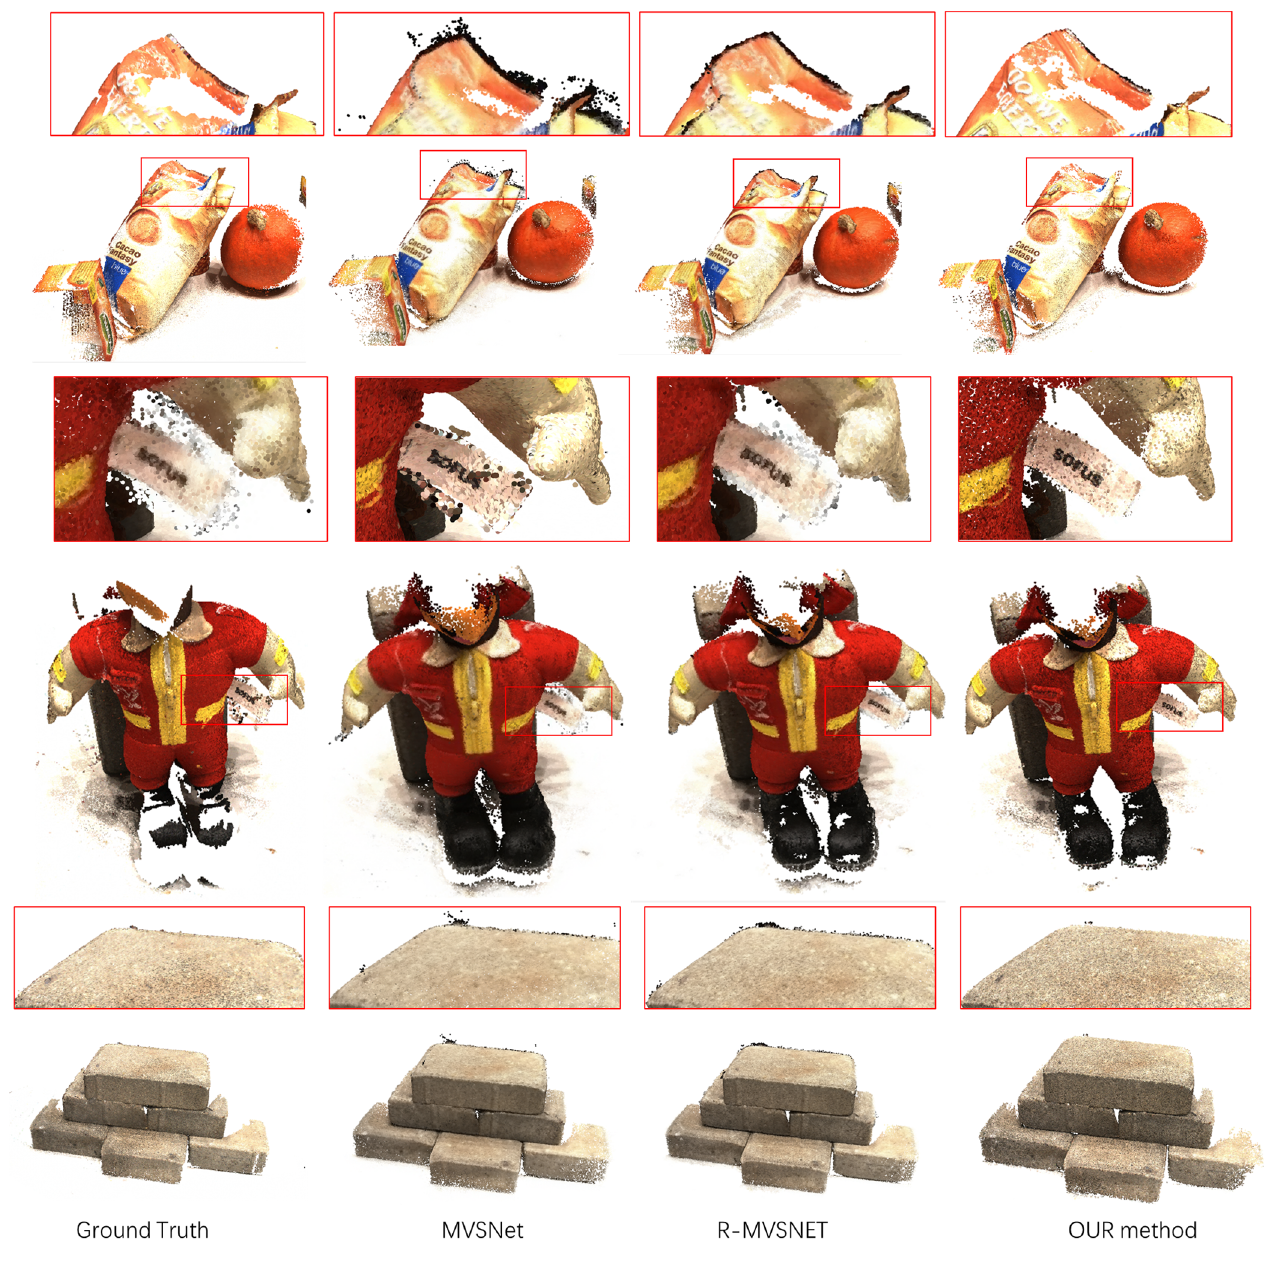
Figure 6. Comparison of 3D point cloud.